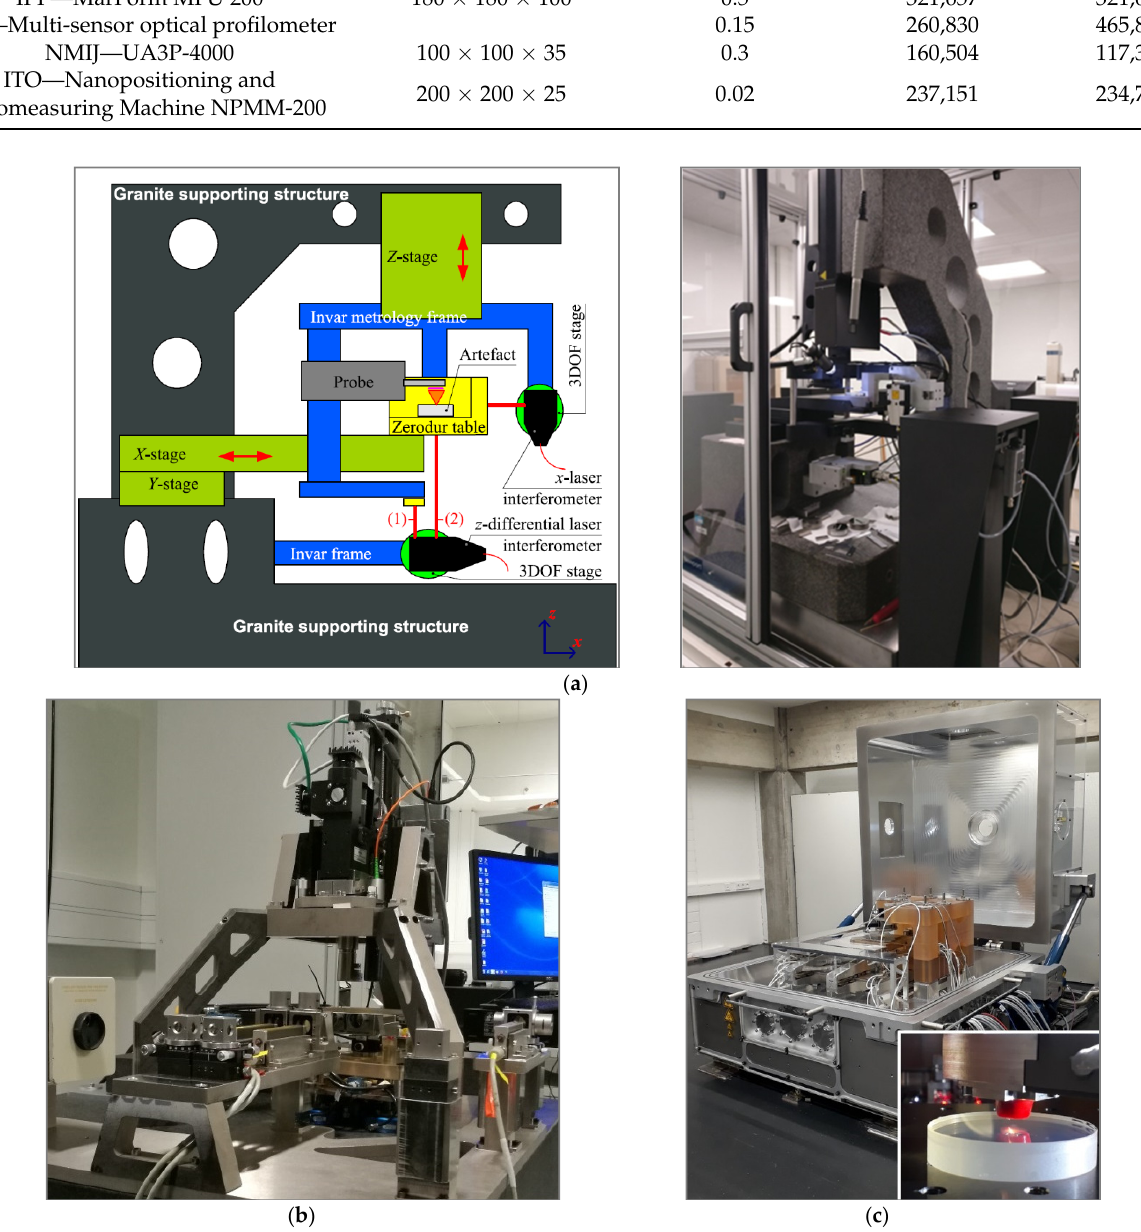
Figure 9. ( a ) LNE’s ultra-high precision primary profilometer, ( b ) VTT’s multi-sensor optical profilometer, ( c ) ITO’s Nano- measuring machine (NPMM-200) and the focus sensor setup. All those measurment instruments are directly traceables to the SI metre definition.